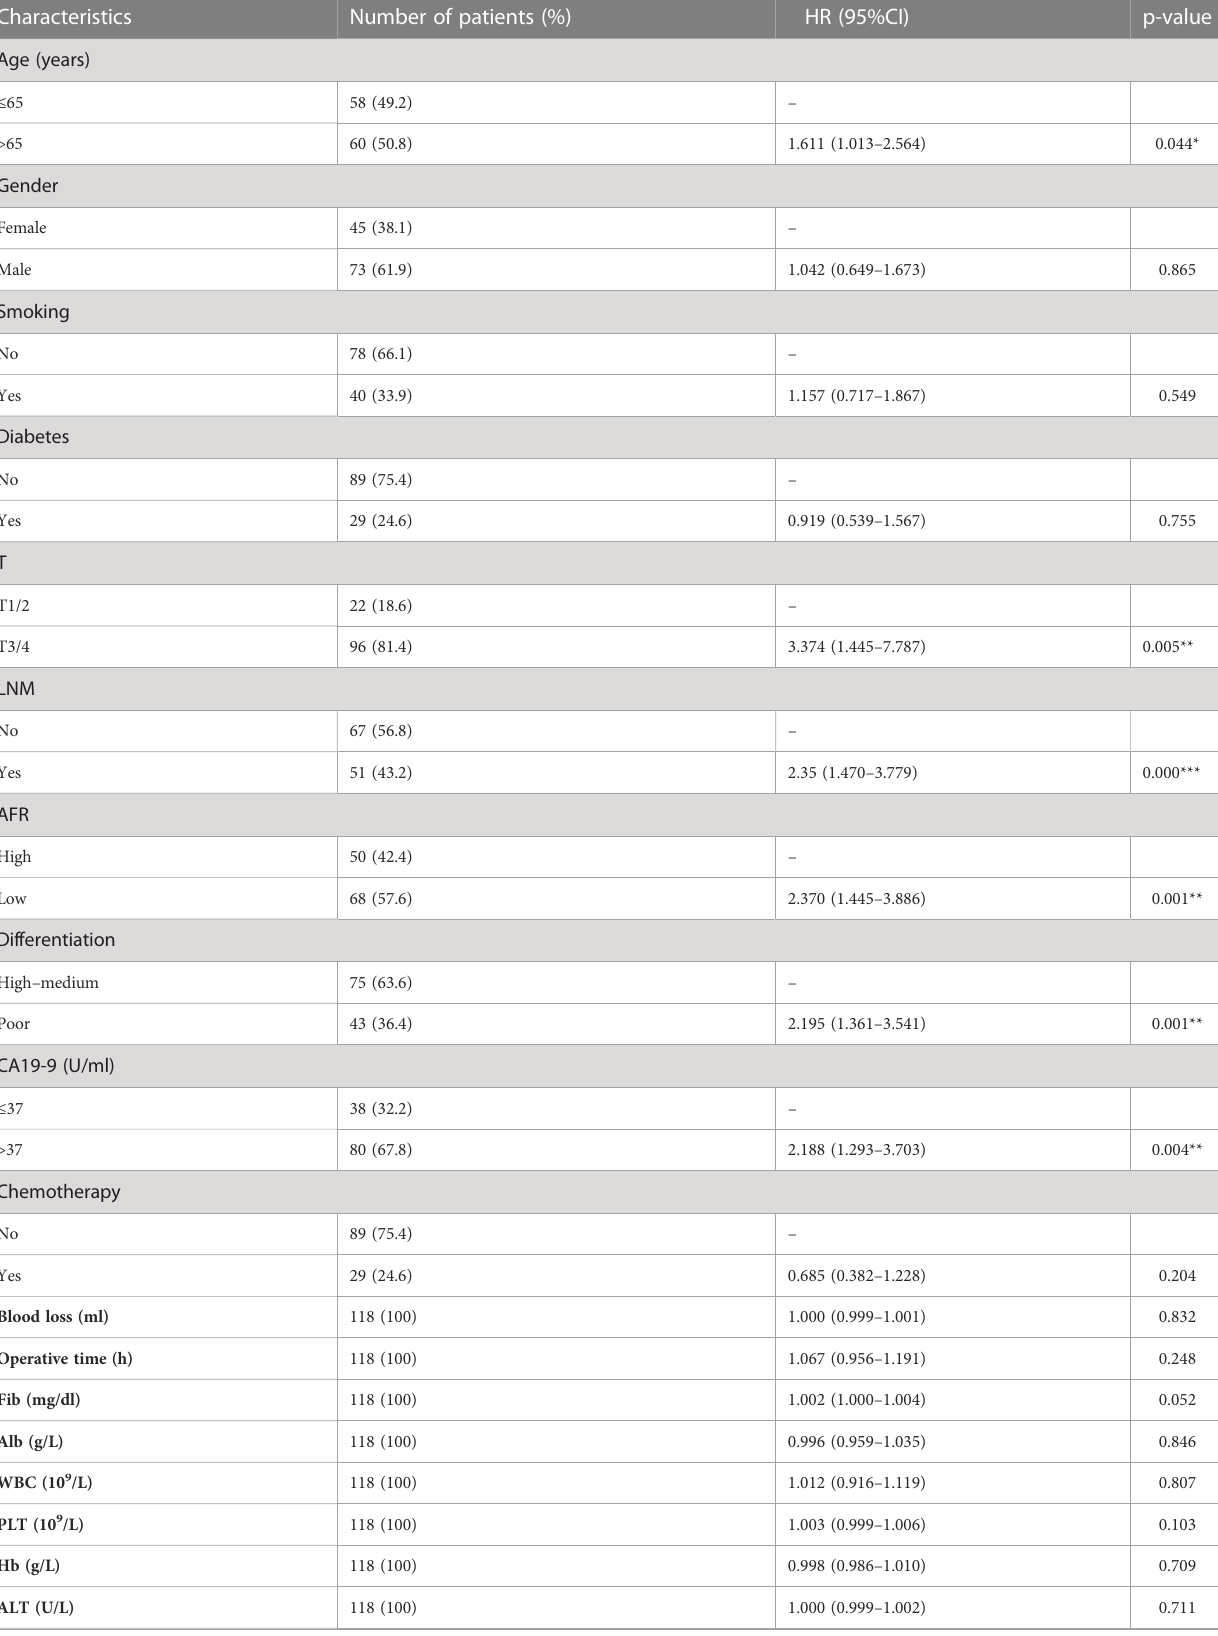
TABLE 2 Univariate Cox regression analyses for predicting OS of patients with dCCA in the training